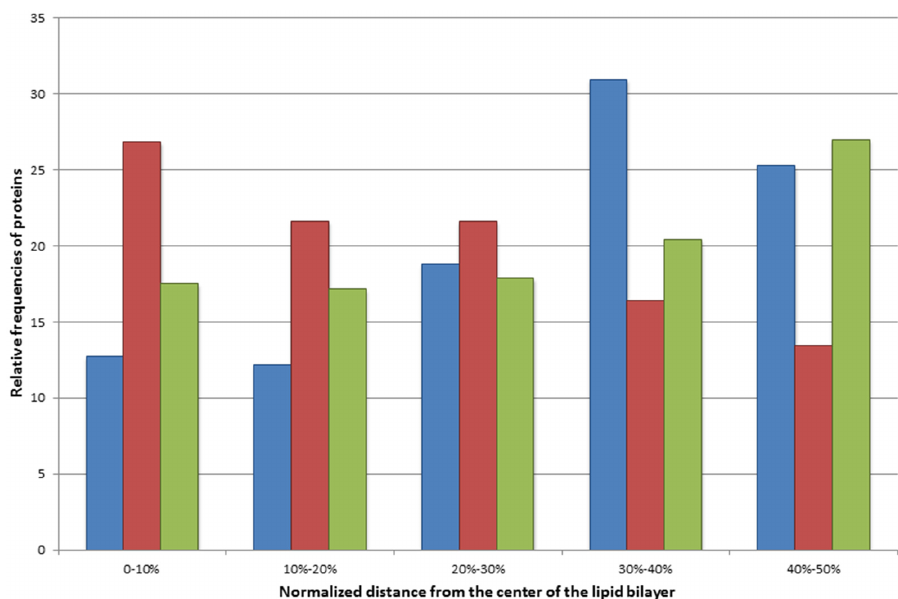
Fig 3. Relative frequencies of mutations in the membrane regions of transmembrane proteins. The distance was measured in the sequence from the most central amino acid in the transmembrane region and was normalized by the length (in residue) of the TM regions. Blue bars represent naturally occurring arginine residues within the TM region. Red bars represent the glycine to arginine disease-associated mutations within the TM region. Green bars represent all polymorphisms found within the TM region.